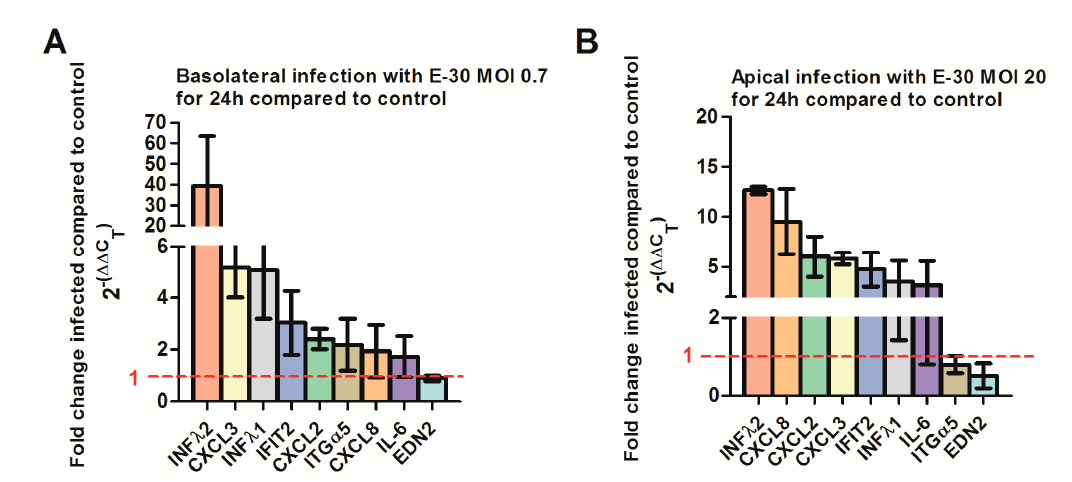
Figure 11. Quantitative PCR determining the regulation of CXCL2, 3, 8, IL-6, IFN λ 1, IFN λ 2, ITG α 5, EDN2 and IFIT2 genes following apical or basolateral infection of HIBCPP cells with E-30. The histograms represent the fold change of HIBCPP cells infected with E-30 in relation to the uninfected control. The fold change was calculated via the 2- ∆∆ C T method using GAPDH as an internal control, and the relative fold change was determined between infected versus uninfected controls. ( A ) Fold change of HIBCPP cell genes following basolateral infection with E-30 at MOI 0.7 for 24 h, ( B ) fold change of HIBCPP cell genes following apical infection with E-30 at MOI 20 for 24 h. Data are shown as mean ± SD of 3 independent experiments, each performed in